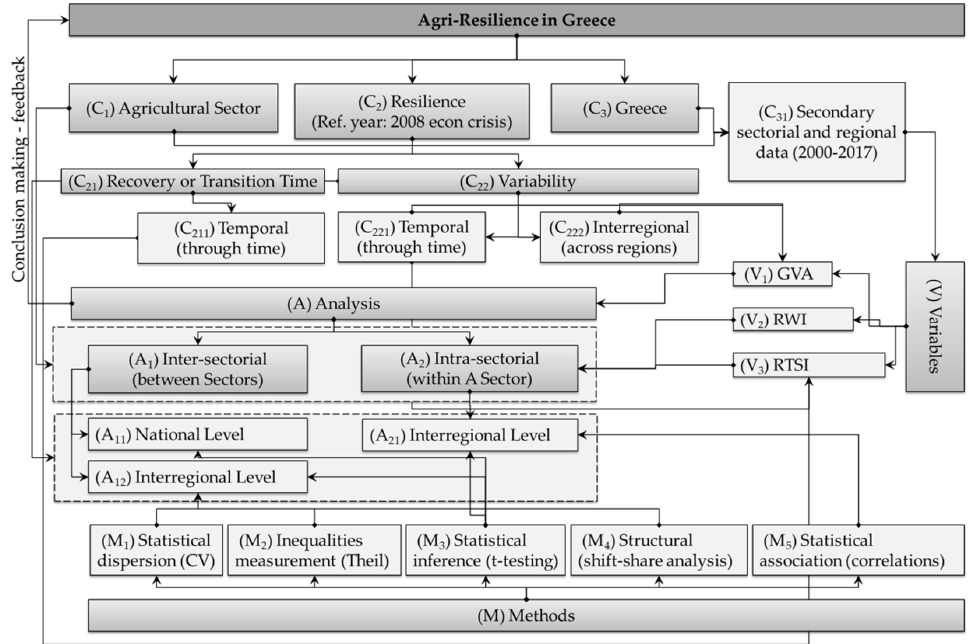
Figure 1. Semantic diagram of the methodological framework of the study.